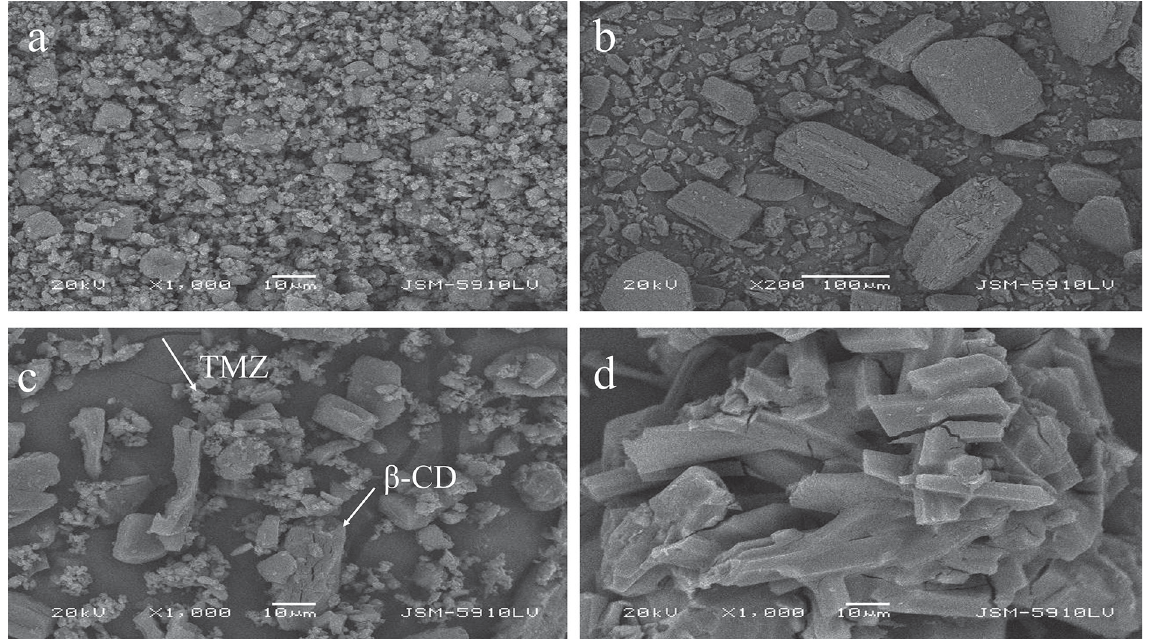
FIGURE 5 - SEM images of (a) TMZ, (b) β -CD, (c) TMZ and β -CD physical mixture where free TMZ and β -CD are clearly marked with arrows (d) TMZ and β -CD inclusion complex where a new structure without free TMZ is